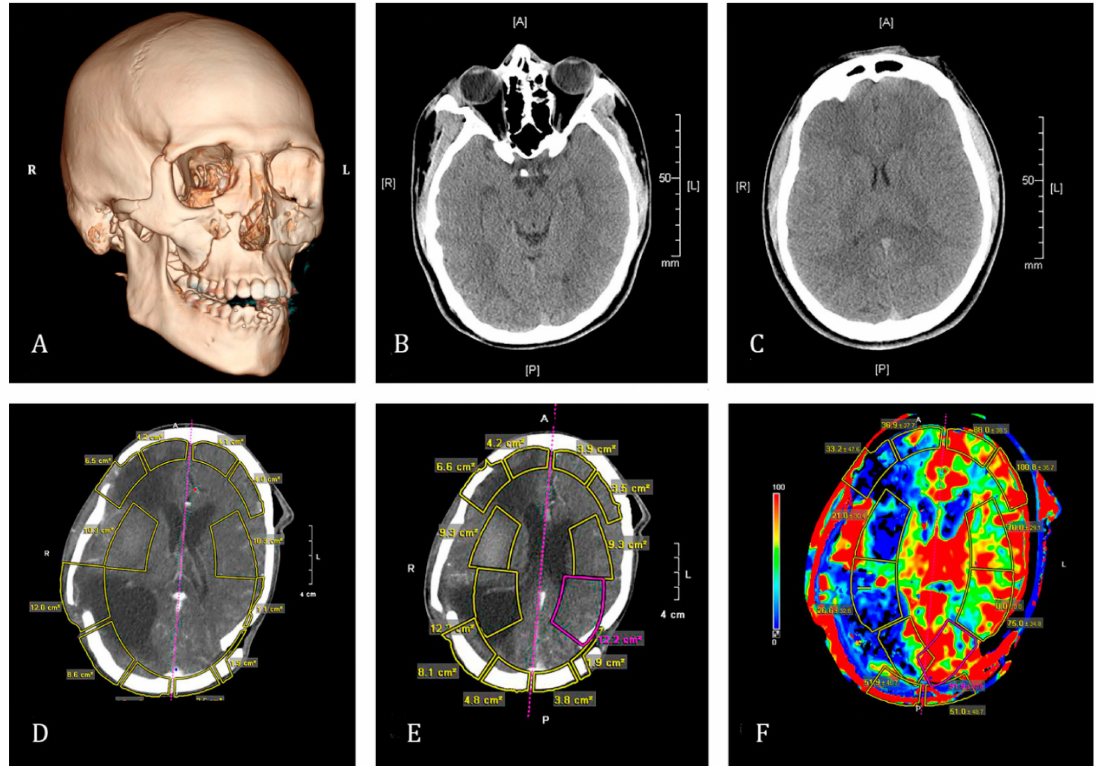
Figure 1. Immediate consequences of the TBI: ( A ) Brain CT-Scan performed four hours after the accident showing the fractures produced in the facial skeleton; ( B , C ) brain cerebral images from the same CT-Scan radiologically informed as normal; ( D , E ) images from a brain CT-Scan performed two months after the accident, observe the important destruction in the right hemisphere; and ( F ) corresponding image to the previous CT-Scan in ( D , E ) after administration of iodinated contrast. Notice the great lack of perfusion in the right hemisphere, while perfusion in the left one was informed as normal. CT- Scans: A = Anterior; P = Posterior; R = Right; L =